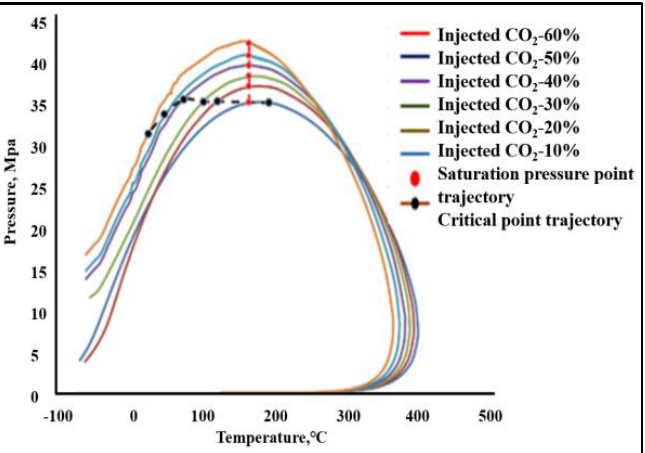
Figure 11. P-T of the system with different CO 2 injection molar quantity.